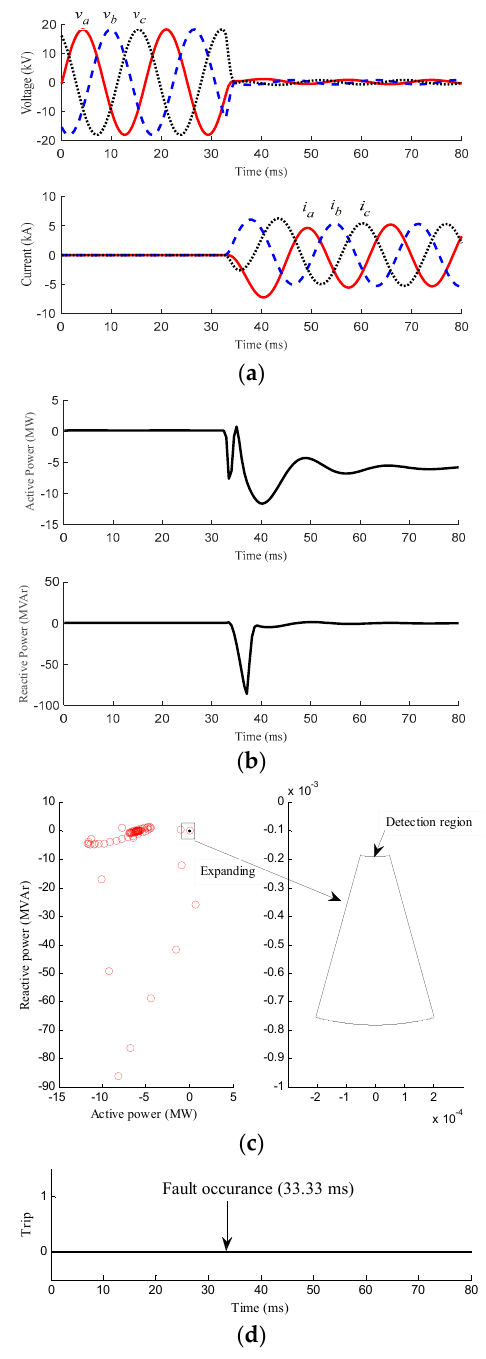
Figure 6. Results for Case 4. ( a ) v a , b , c (upper) and i a , b , c (lower); ( b ) p 3 ph (upper) and q 3 ph (lower); ( c ) Trajectories of the point ( p 3 ph , q 3 ph ); ( d ) Islanding detection signal.